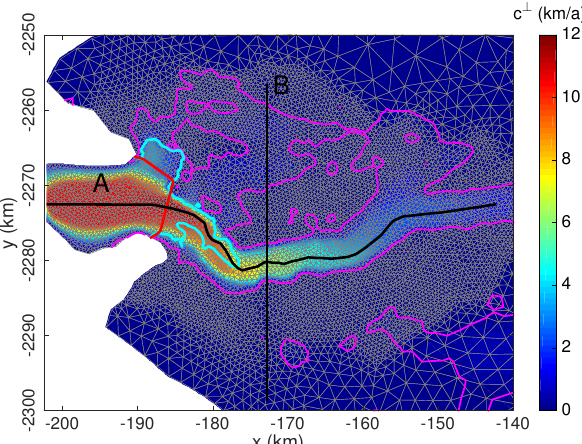
Figure 4. Calving rate field c ⊥ in the region of fast flow, derived 0 from modelled ice velocities at the end of the relaxation run. The red line indicates the 0 level set of the initial LSF used for geome- try relaxation and as start position for the calving front during the experiments. The turquoise line marks the grounding line. Purple contours indicate zero bedrock elevation. Black lines are the “along- trough” (a) and “across-trough” (b) profiles used in Fig. 6. The finite element mesh is displayed in